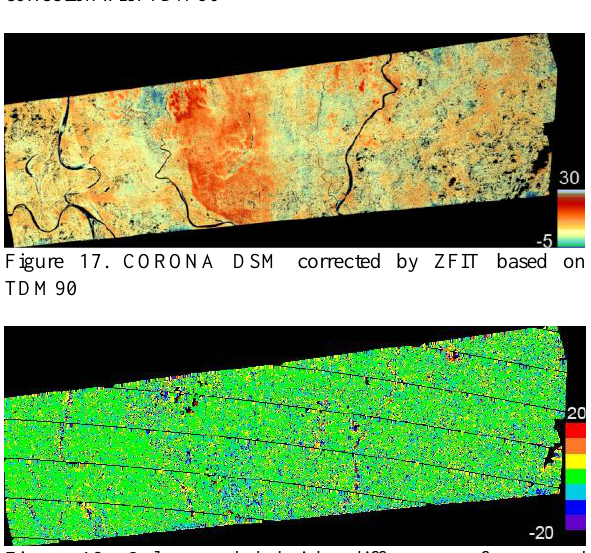
Figure 18: Colour coded height differences of corrected CORONA DSM against TDM90